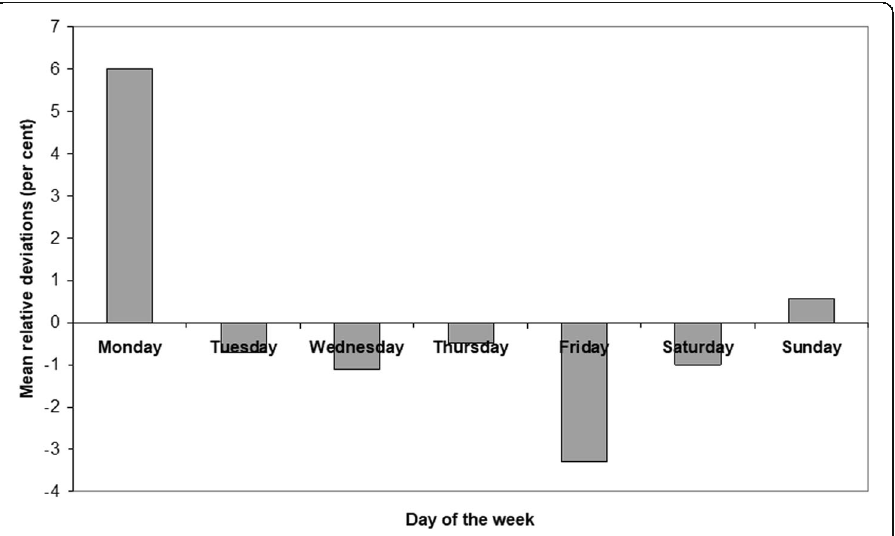
Fig. 1 Percentage difference of daily number of livebirths from the weekly average. Italy,